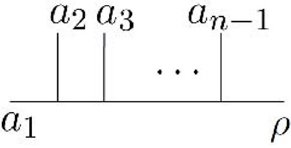
Figure 17 . A half-ladder diagram where a 1 and the off-shell line n (with the Lorentz index ρ ) play as the two